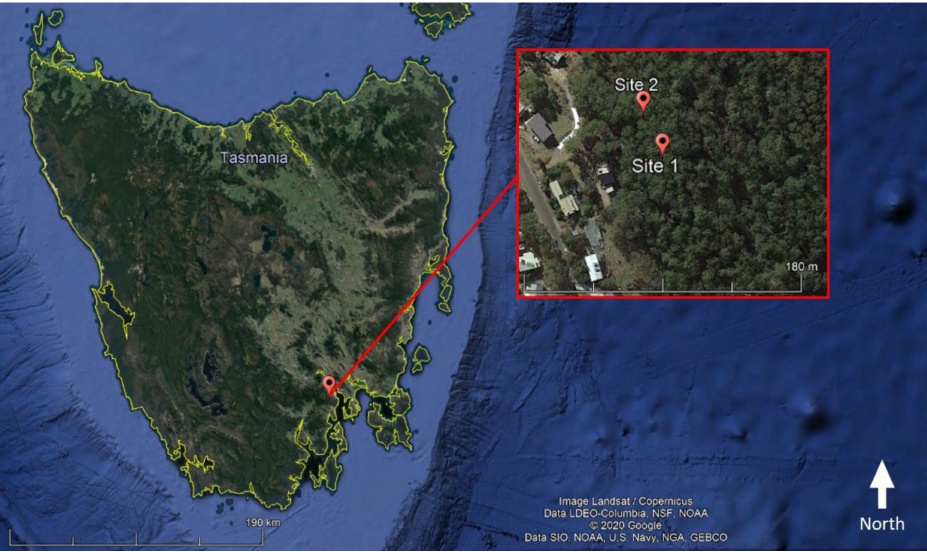
Figure 2. Study site location in Fern Tree, Tasmania, Australia [22]. Coordinates: − 42.925, 147.272. Table 1. Site conditions of the two study sites. Diameter at 150 cm above ground level (D150) was reported as this is the most comparable to diameter at breast height (130 cm above ground) commonly used in similar